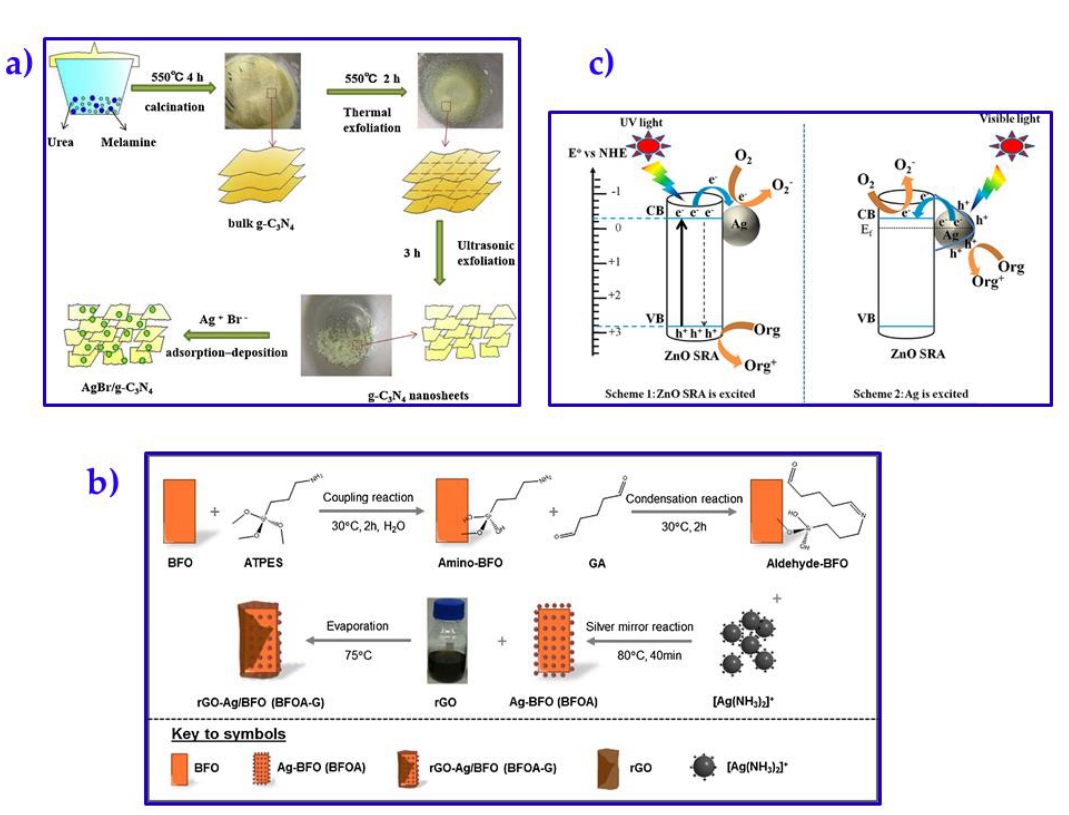
Figure 5. Preparation protocols of novel composite material, such as ( a ) AgBr/g–C 3 N 4 [46], ( b ) rGO– Ag/Bi 2 Fe 4 O 9 [48]. ( c ) Mechanism of action of Ag−ZnO in photocatalysis against organic pollutants under solar light irradiation